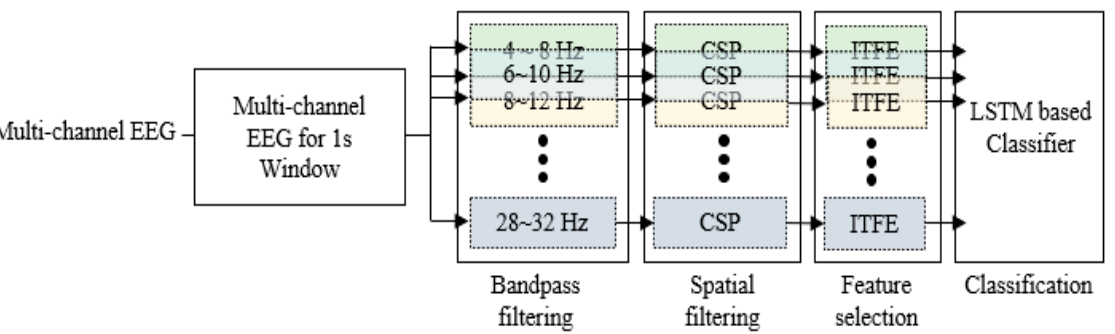
Figure 2. Processing steps of the filter bank common spatial